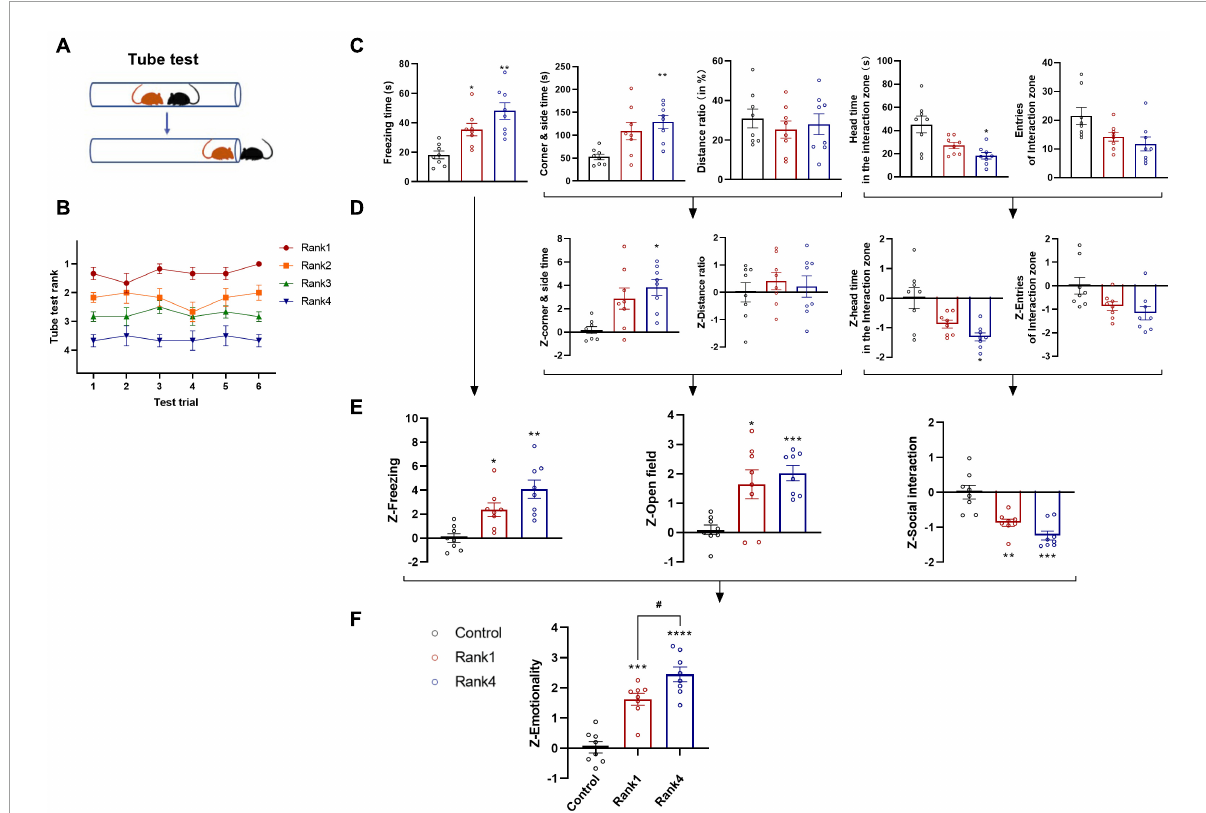
FIGURE9 Social hierarchy affects social fear transfer. (A) Schematic of the tube test. (B) Overall rank stability shows the average rank of animals belonging to each rank group (as determined at the end of the tube test) calculated for each day of testing. (C) Raw data are obtained from three behavioral tests (FZ, OF, and SI; n = 8/group) performed on the same animals. (D) Normalization of data using the Z -score method was performed for each parameter. (E) Test Z -values were then calculated by averaging individual Z -scores, and (F) averaged to obtain the emotionality score. Data represent mean ± SEM ( n = 8/group). * p < 0 . 05; ** p < 0 . 01; *** p < 0 . 001 and **** p < 0 . 0001 for effects of dominate (Rank 1) and subordinate (Rank 4) group compared to the control group. # p < 0.05 for effects between Rank 1 and Rank 4